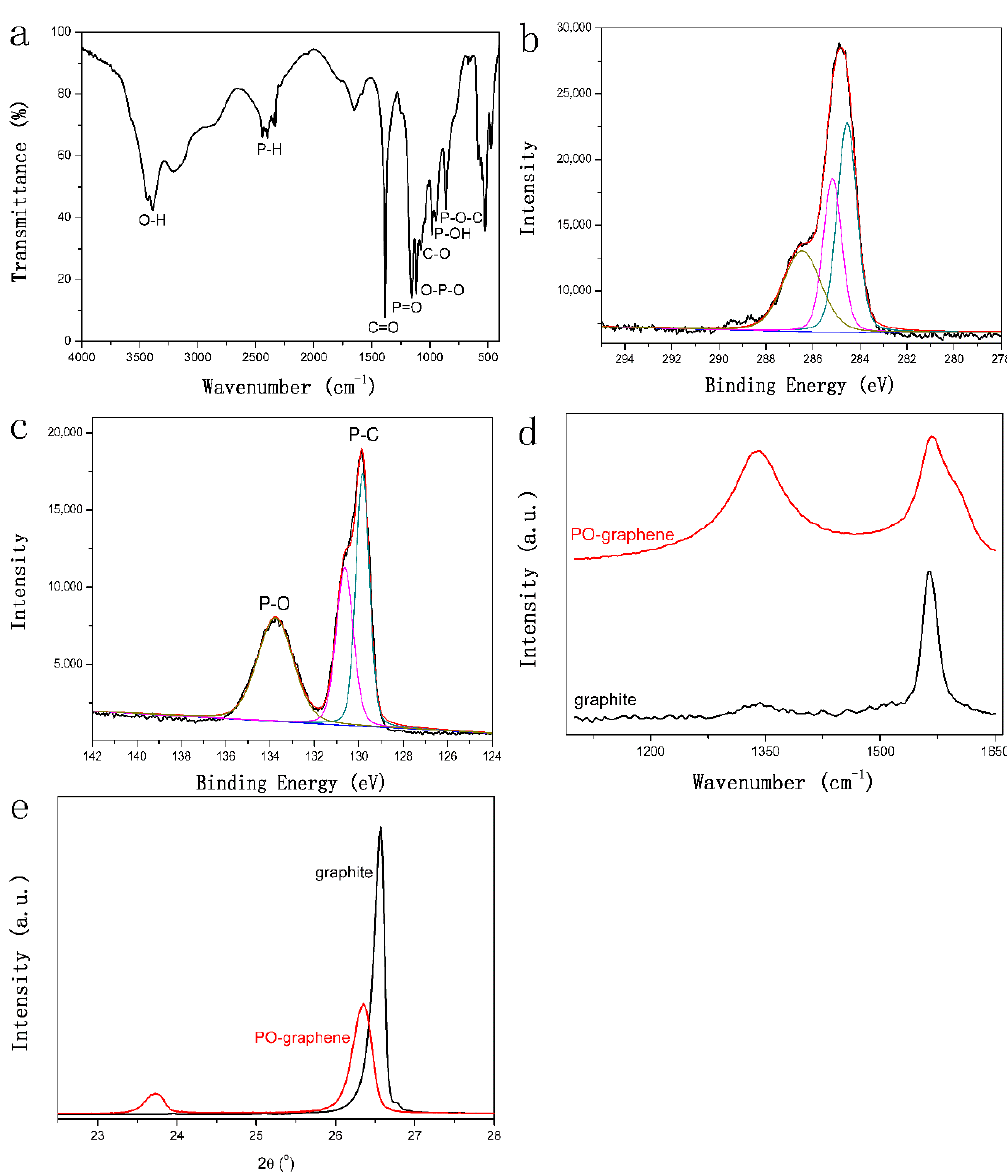
Figure 2. ( a ) Fourier transform Infrared spectroscopy (FT-IR) analysis of PO-graphene; ( b ) high-resolution C1s spectrum of PO-graphene; ( c ) high-resolution P2p spectrum of PO-graphene; ( d ) Raman analysis patterns of PO-graphene and graphite and ( e ) X-ray diffraction analysis (XRD) patterns of PO-graphene and graphite.